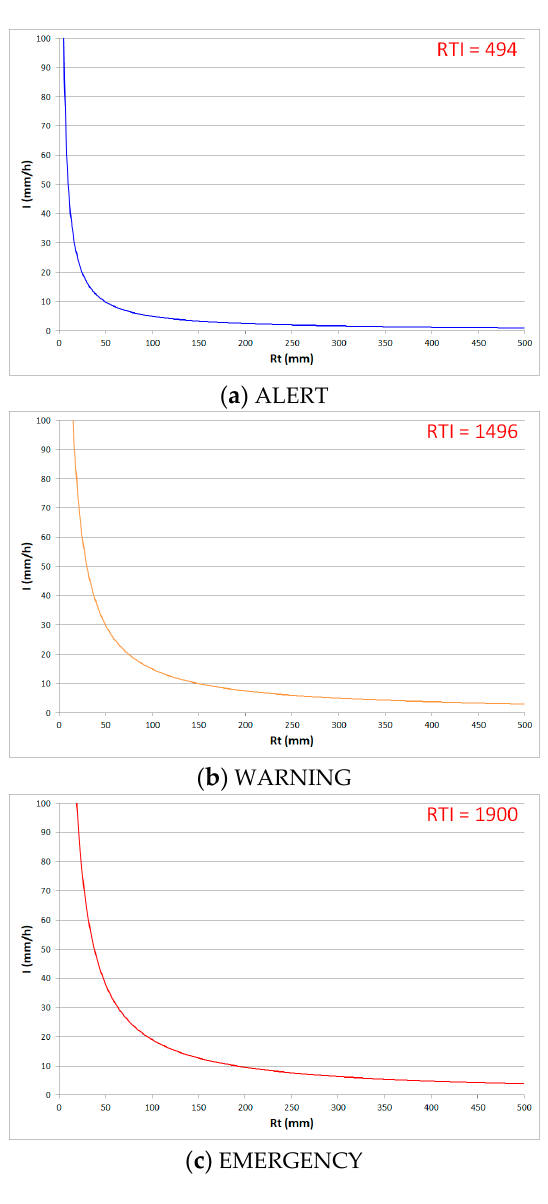
Figure 9. Estimation of rainfall triggering index (6 h): ( a ) ALERT; ( b ) WARNING; ( c ) EMERGENCY.